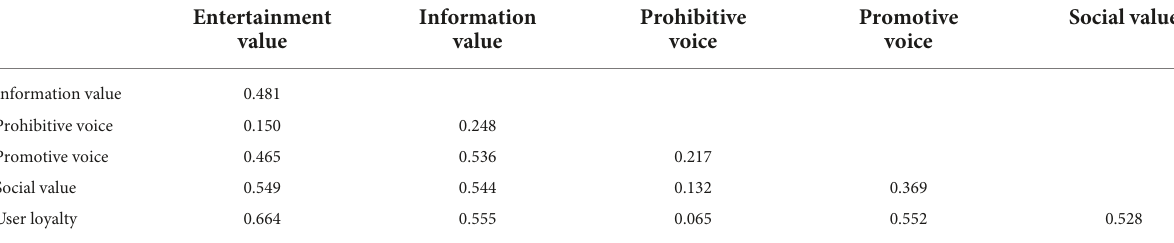
TABLE 3 Results of discriminant validity by HTMT.